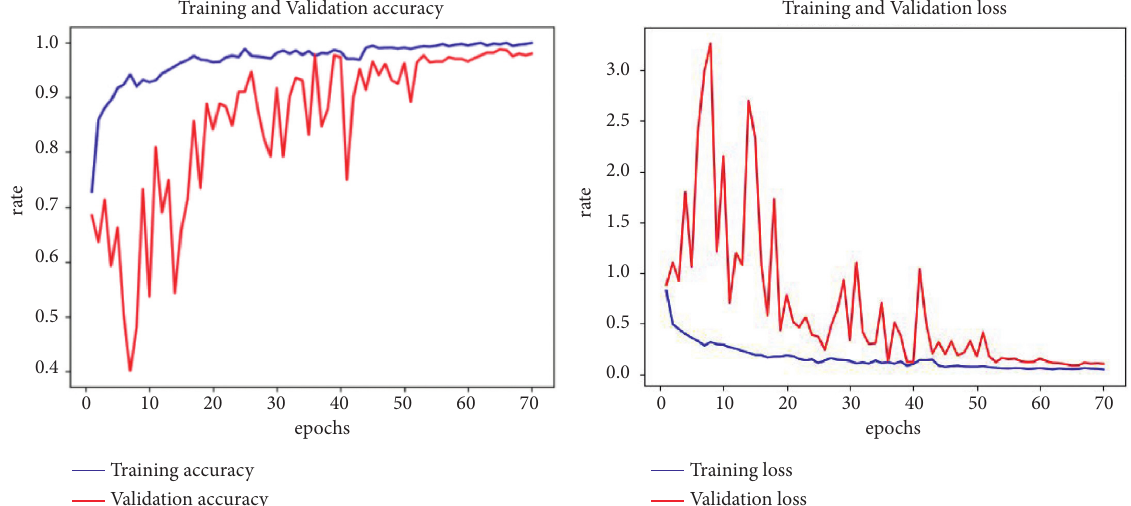
Figure 16: Accuracy and loss rates on a subset of apple data.